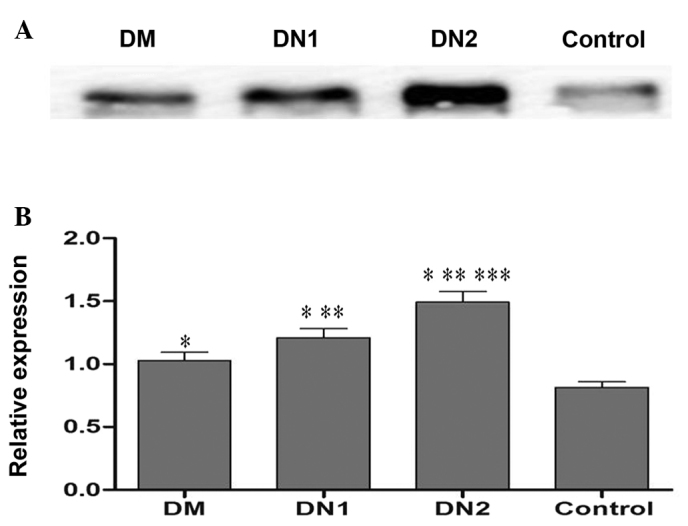
VDBP expression levels were verified in the urine samples. (A) Western blot analysis of VDBP expression in urine samples of DM, DN1, DN2 and control groups. (B) VDBP protein expression levels in individual urine samples was calculated according to the immunosignals quantified by densitometric scanning. Data are expressed as the mean ± standard deviation from three independent experiments. *P<0.05 compared with that of the control group; **P<0.05 compared with that of the DM group and ***P<0.05 compared with that of the DN1 group. DM, UACR<30 mg/g; DN, diabetic nephropathy; DN1, with microalbuminuria 30<UACR<300 mg/g; DN2, with microalbuminuria UACR>300 mg/g; UACR, urinary albumin:creatinine ratio; VDBP, vitamin D binding protein; UACR, urine:creatinine ratio.